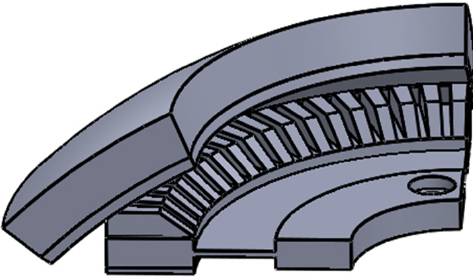
Figure 17. Friction contact model.